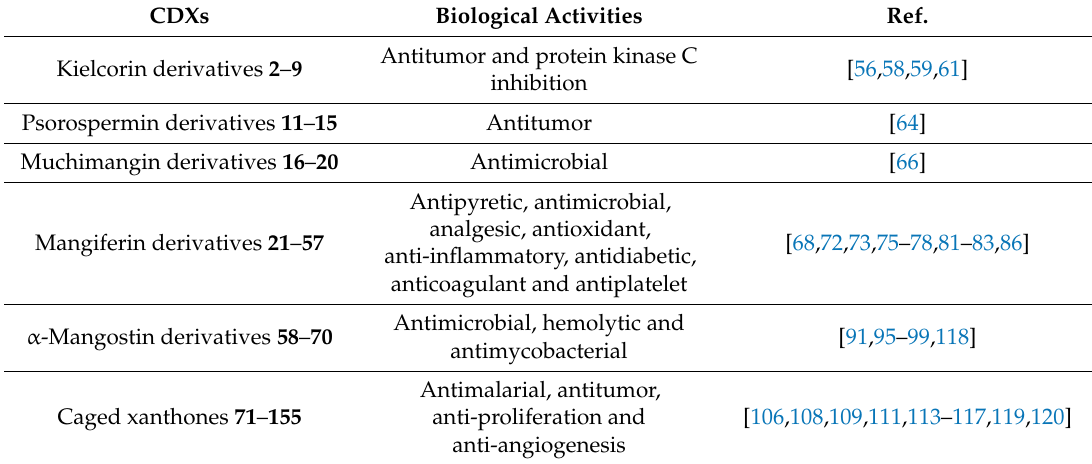
Table 1. Summary of the biological activities of synthetic CDXs inspired in natural xanthones.